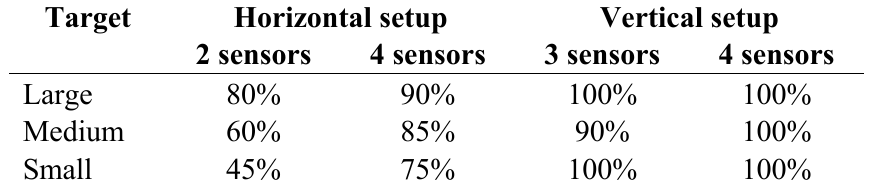
Table 1. The height localization probability (for a distance of 25 cm from the exact position).